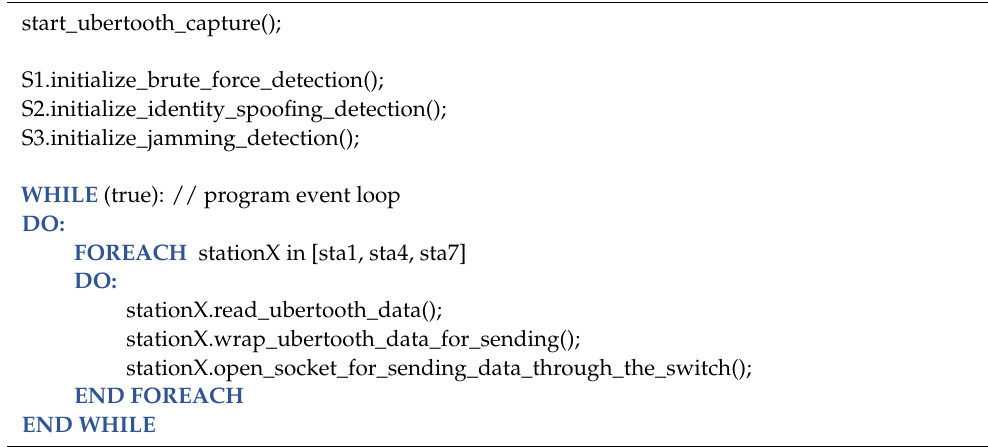
Algorithm 2 Reading Waspmote sensor